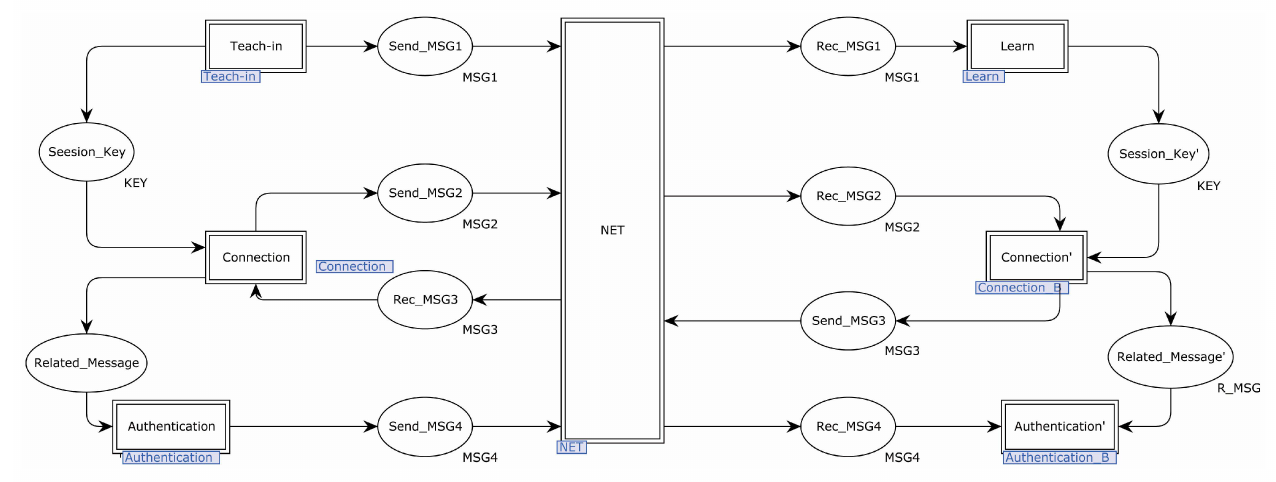
Figure 2. EnOcean protocol top-level model.